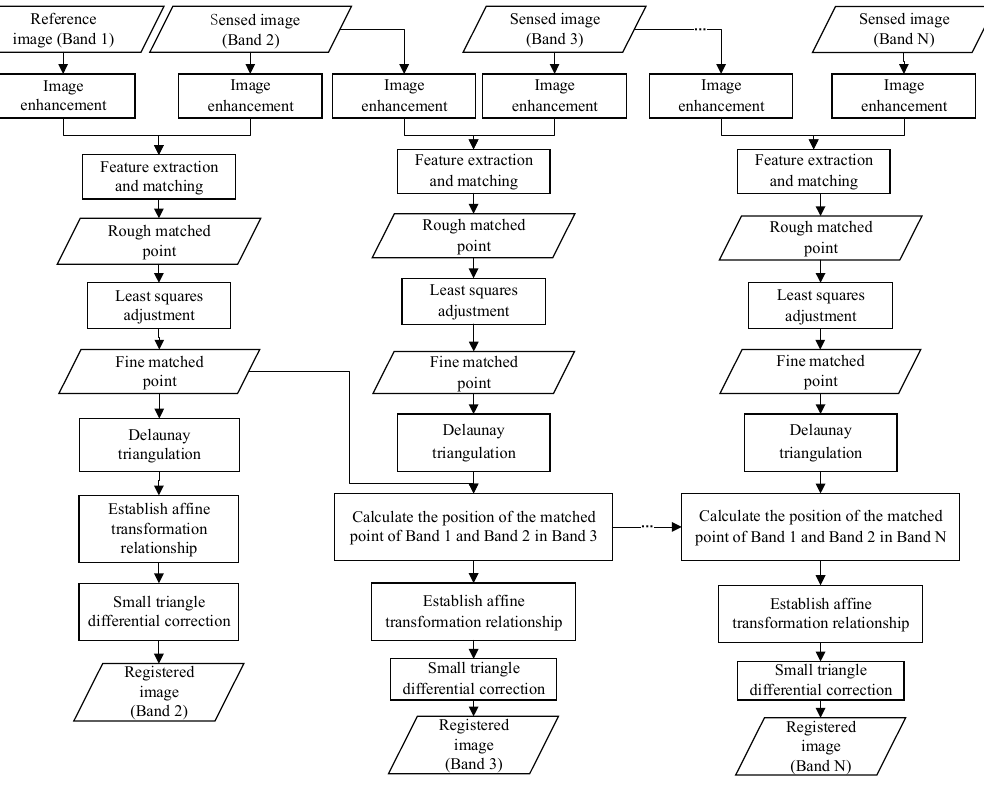
Figure 4. Full-spectrum registration workflow.